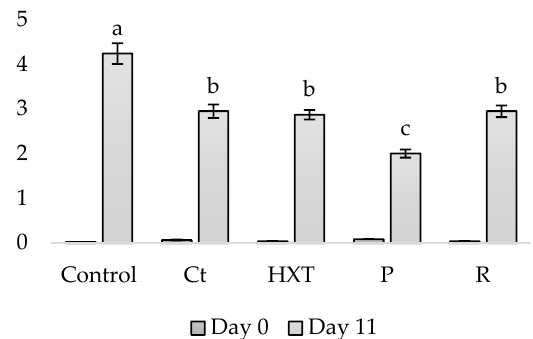
Figure 4. Evolution of hexanal (AU × 10 − 6 per g dry mater) (mean area ± standard deviation) of fish patties, elaborated with di ff erent natural extracts, after 11 days of at 4 ◦ C under simulated retail display conditions. Control: 200 ppm acerola + 200 ppm citric extract (Ct); 200 ppm acerola + 200 ppm hydroxytyrosol extract (HXT); 200 ppm acerola + 200 ppm pomegranate extract (P); 200 ppm acerola + 200 ppm rosemary extract (R). Di ff erent letters (a, b, c) in the same column indicate significant di ff erences between samples ( p < 0.05).